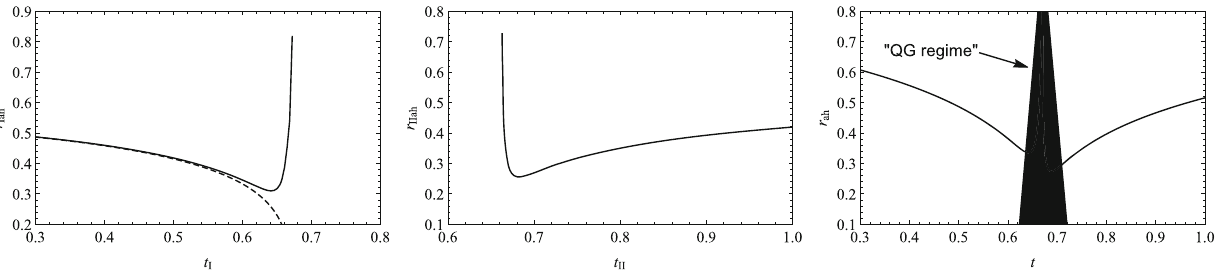
phase. In the right panel we plot a schematic of the apparent horizon curve both before and after collapse. The values of the parameters